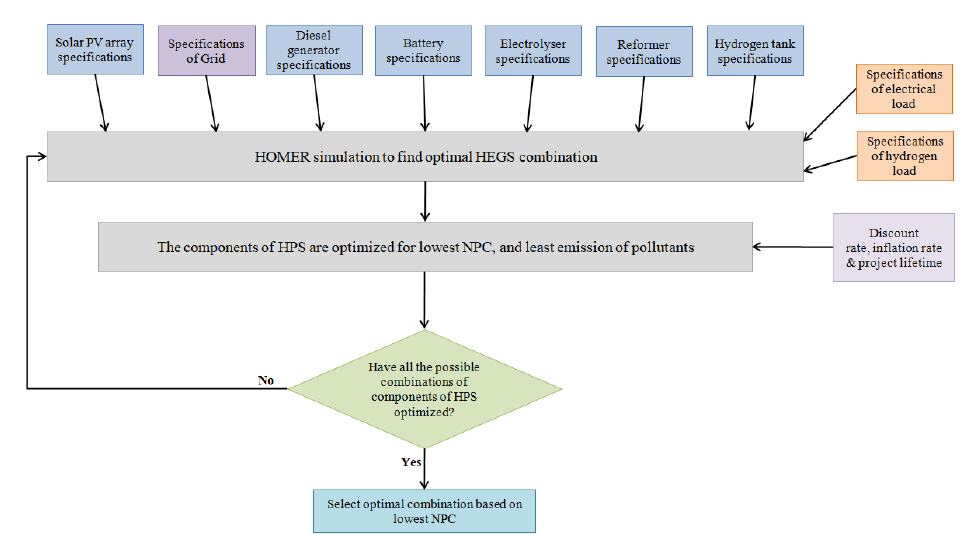
Figure A1. Flow chart of HOMER software.